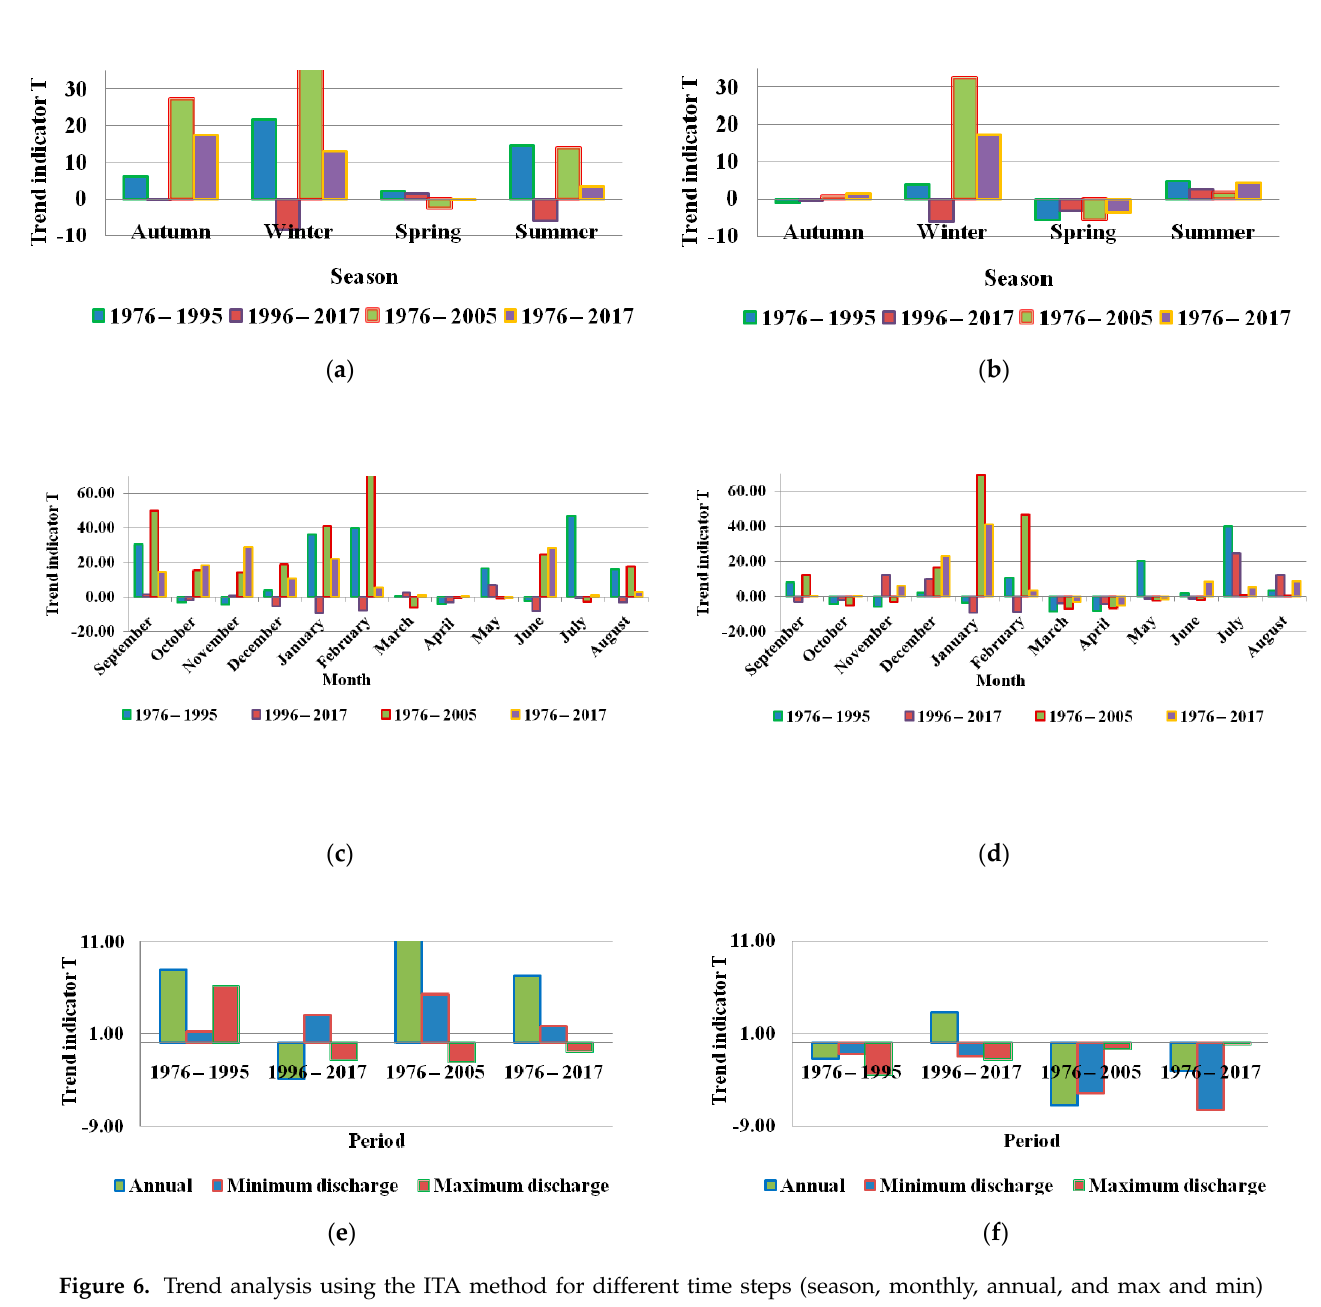
Table 5. Annual average hydrological variables and climate elasticity for the different periods of the Merguellil water- shed.